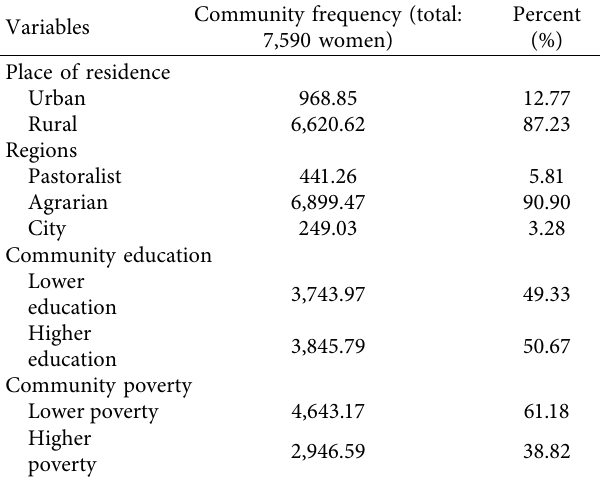
Table 2: Sample characteristics of community level of women